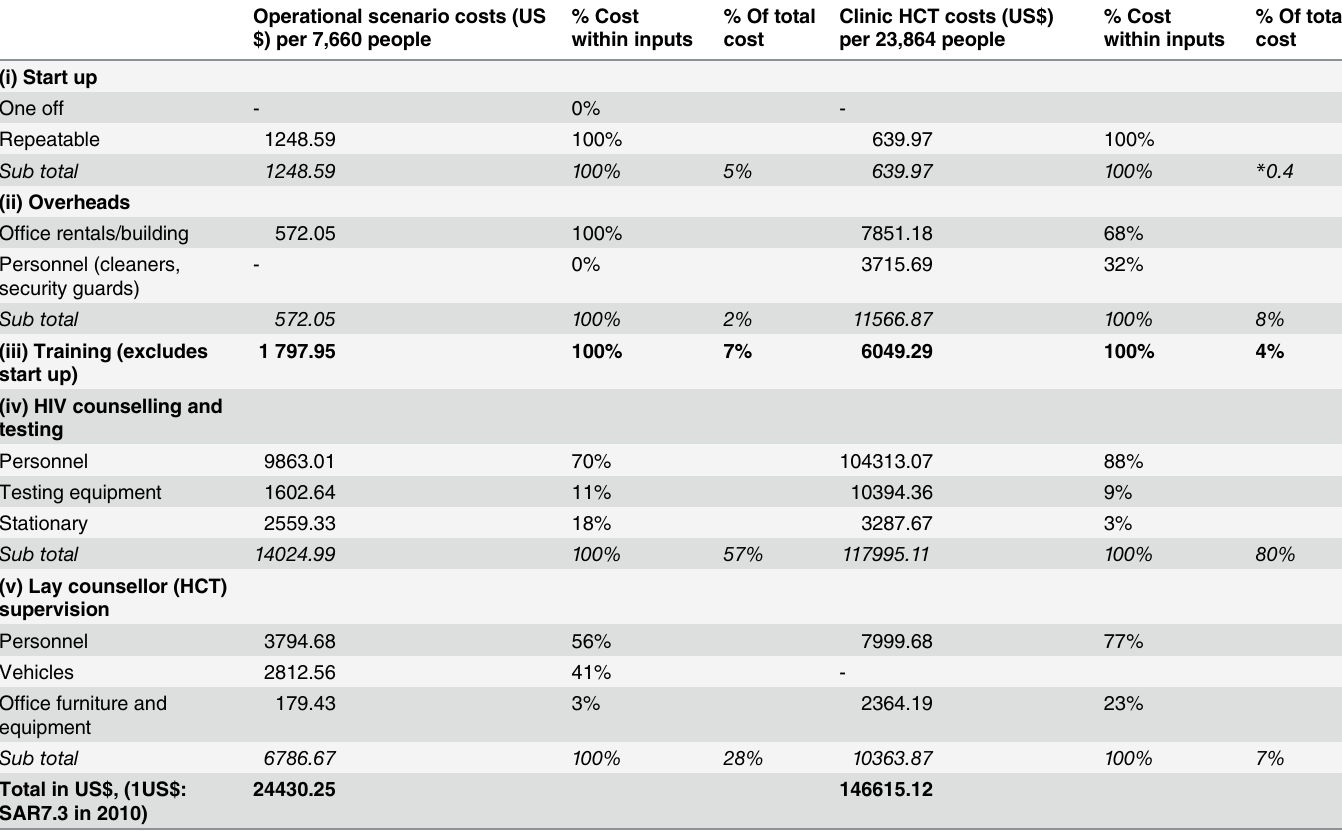
Table 5. Comparison of costs between clinic HCT and operational